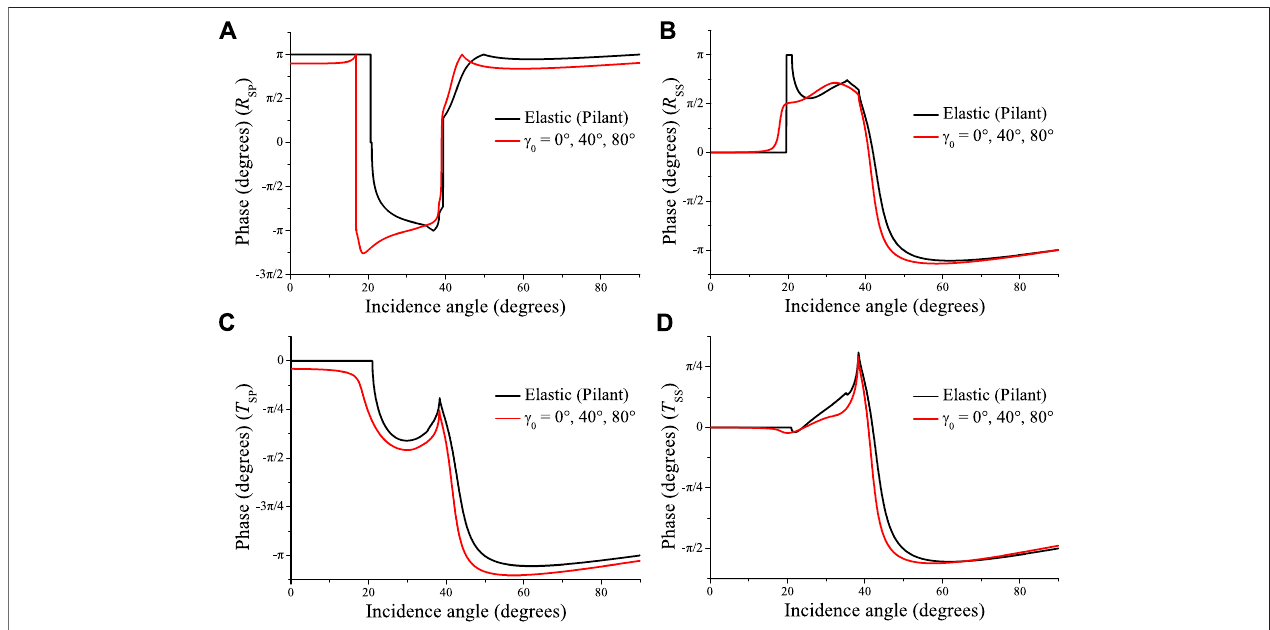
FIGURE 9 | Same as Figure 8 but for the phase angles of the re fl ected P (A) , re fl ected S (B) , transmitted P (C) and transmitted S (D) waves.